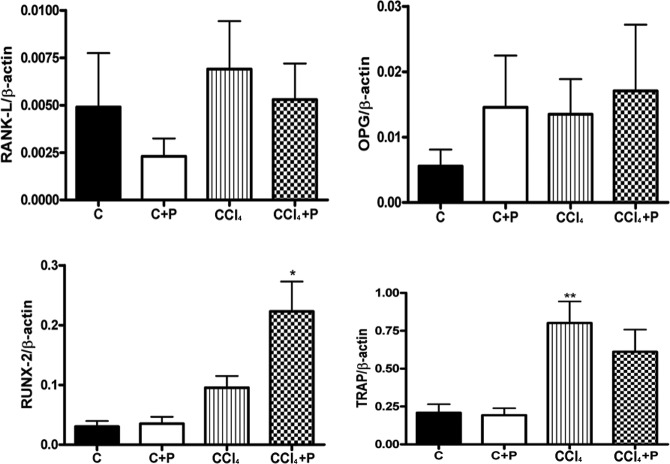
Bone mRNA levels of RANKL, osteoprotegerin, RUNX-2, and TRAP in the four groups (C, C+P, CCl4, and CCl4+P). All expression levels are presented relative to β-actin expression (RT-PCR). N=6 per genotype. * CCl4+P > C, C+P, and CCl4; ** CCl4 > C and C+P, p<0.05.